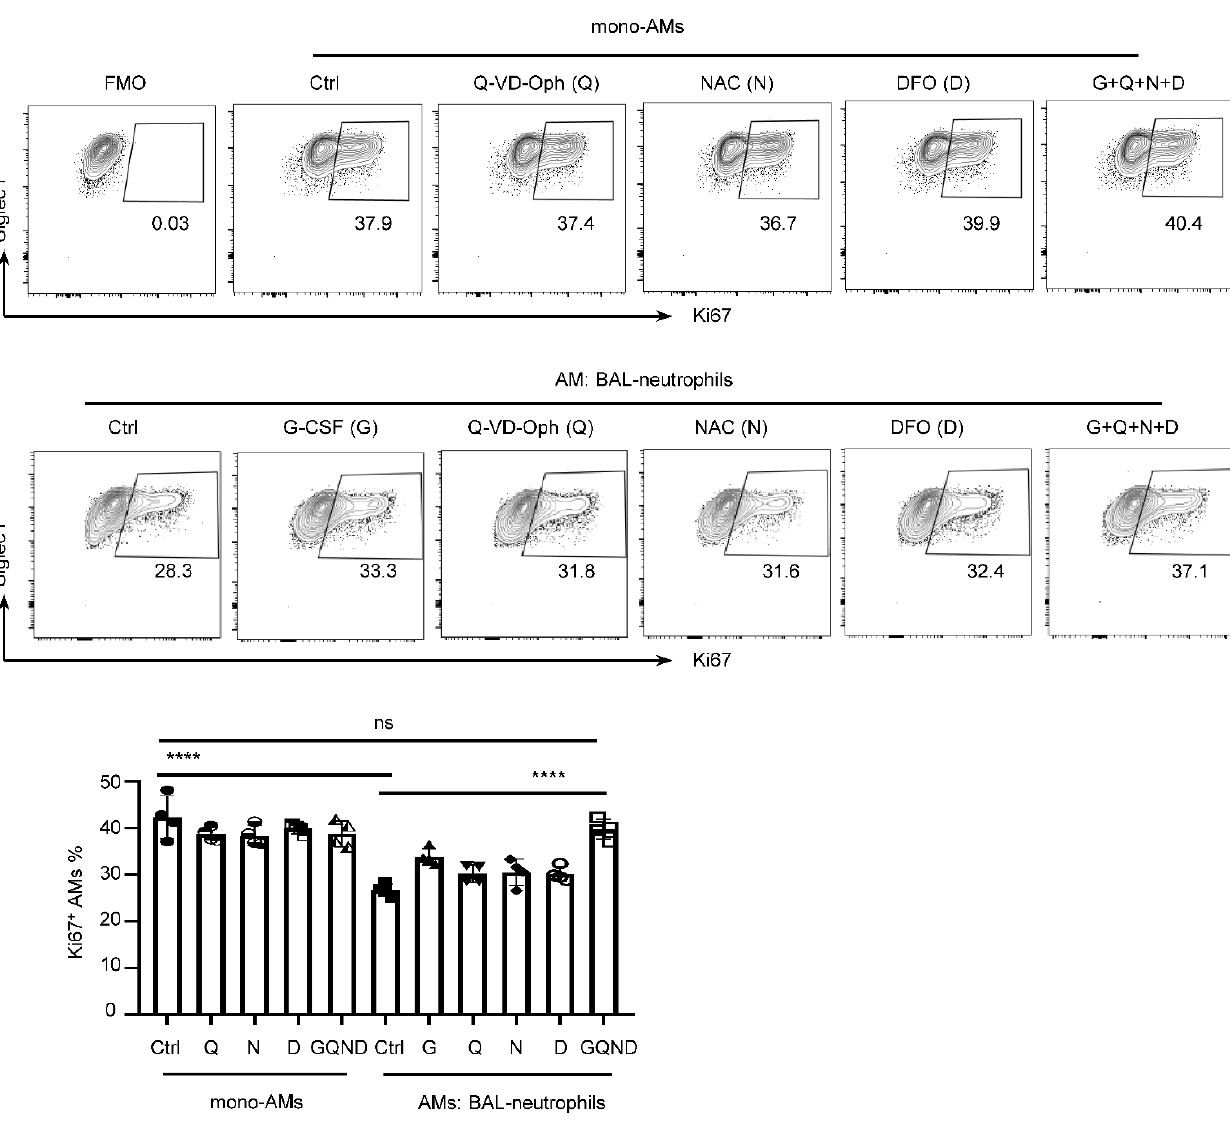
Figure 6. Multiple cell death pathways of BAL − neutrophils affect AM proliferation. Representative flow cytometry plots and frequencies of Ki67 + AMs treated with G-CSF (10 ng/mL), Q-VD-Oph (50 µ M), NAC (1 mM), DFO (1 µ M) in AMs co-cultured with or without BAL − neutrophils at a 1:1 ratio. Data are presented as arithmetic mean ± SD. ns, no significant; **** p < 0.0001.